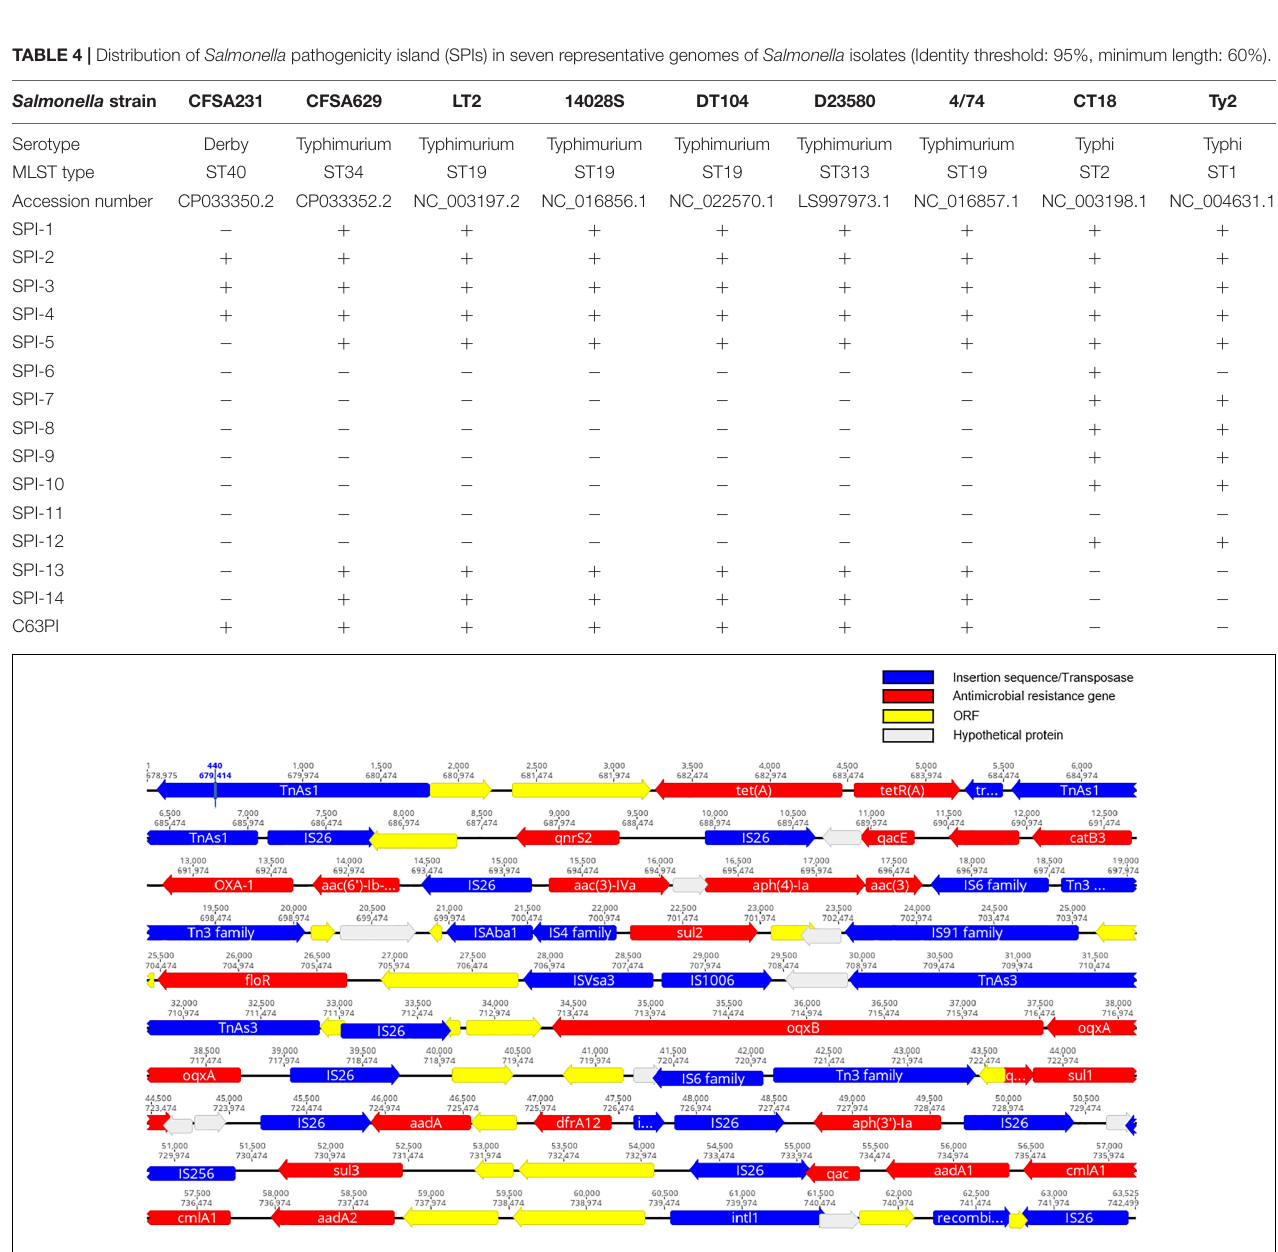
FIGURE 3 | A schematic illustration showing the structural of ∼ 64kb MDR gene cluster region on chromosome of CFSA231 (created using Geneious software). Antimicrobial resistance (AMR)-encoding genes are indicated in red boxes/arrows. Blue boxes/arrows denote transposon- and integron-associated genes. The individual open reading frame (ORF) are indicated with yellow boxes/arrows. The light gray boxes indicate hypothetical proteins.